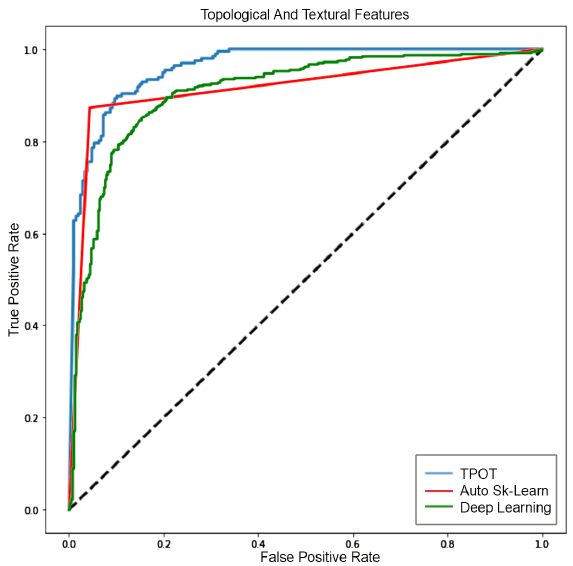
Figure 15. Comparison of ROC curves for the three machine learning approaches trained with topological and textural features.